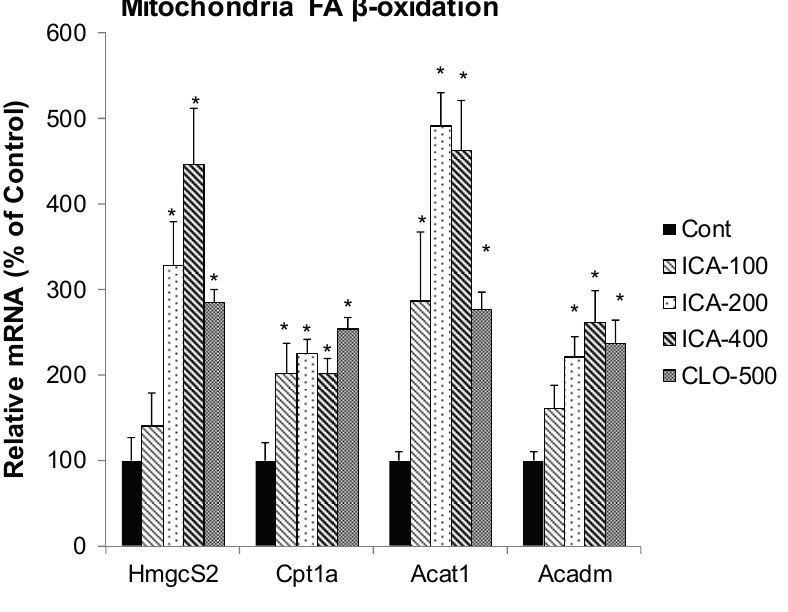
Figure 3. Effects of Icariin (ICA) on expression of mitochondrial fatty acid β -oxidation enzymes. Data are expressed as mean ± SEM (n = 5). * Significantly different from CMC-treated mice ( p <